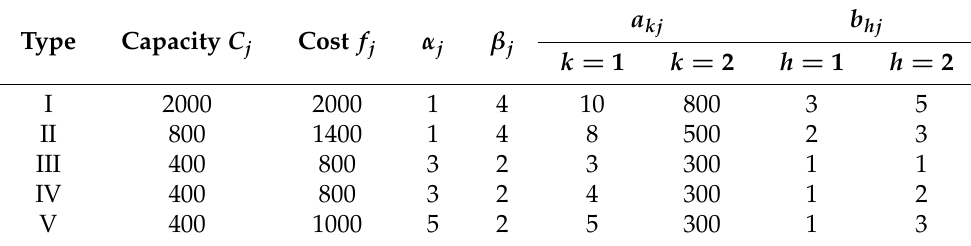
Table 2. Parameter settings for the various types of candidate NAT sites.